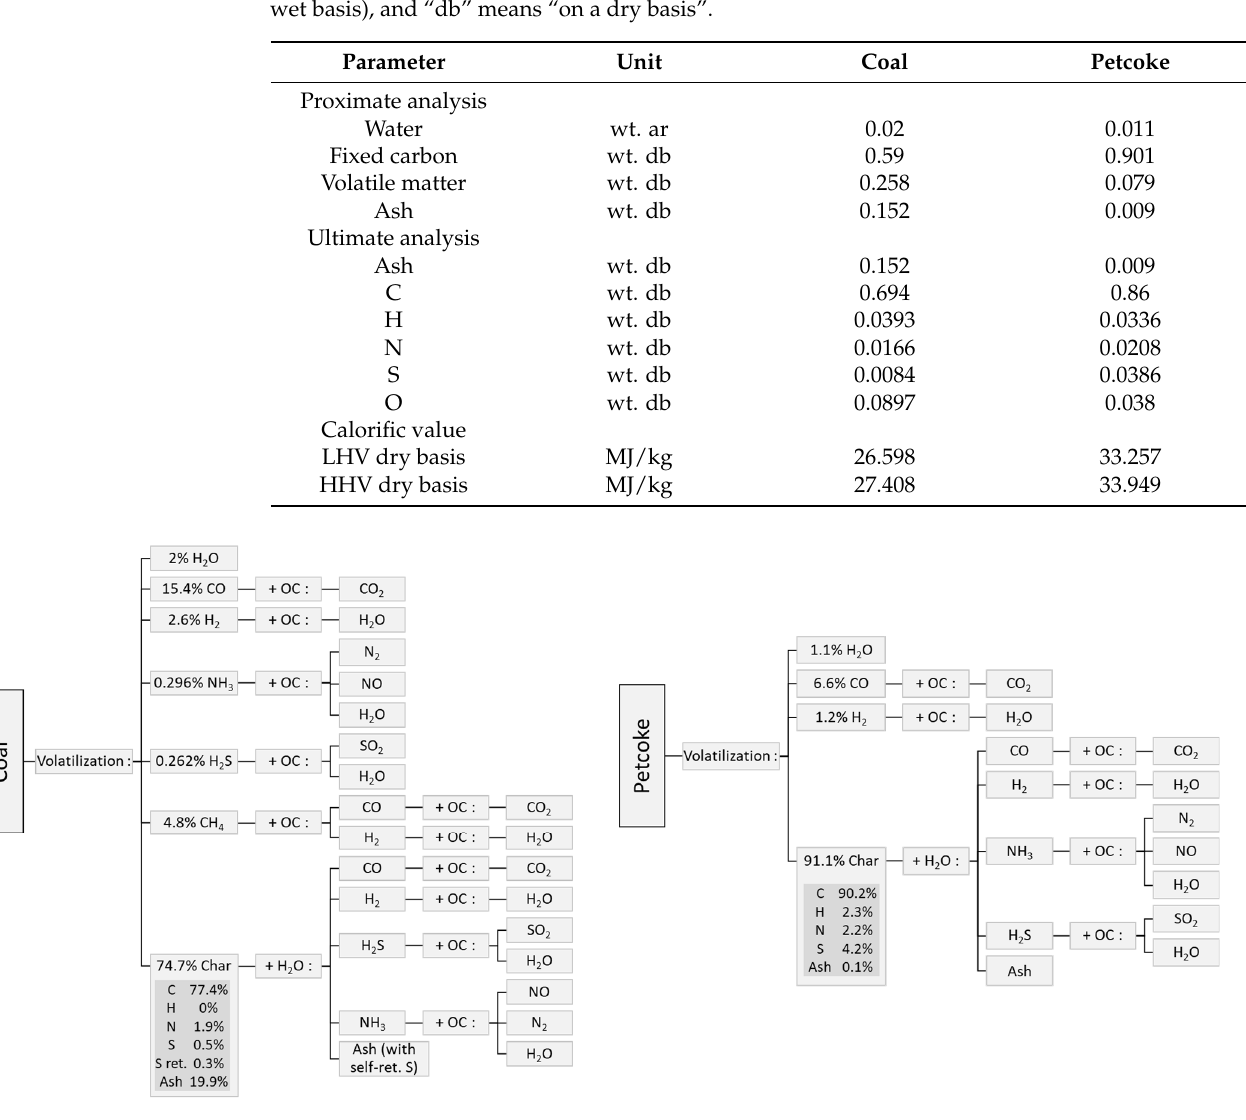
Figure 2. Reaction paths in the FR. Fractions are given on mass basis. Table 2. Solid fuels’ characteristics. “wt.” means “mass fraction”, “ar” means “as received” (i.e., on a wet basis), and “db” means “on a dry basis”. Table 3. OC characteristics. R OC is expressed in kg of oxygen per kg of fully oxidized